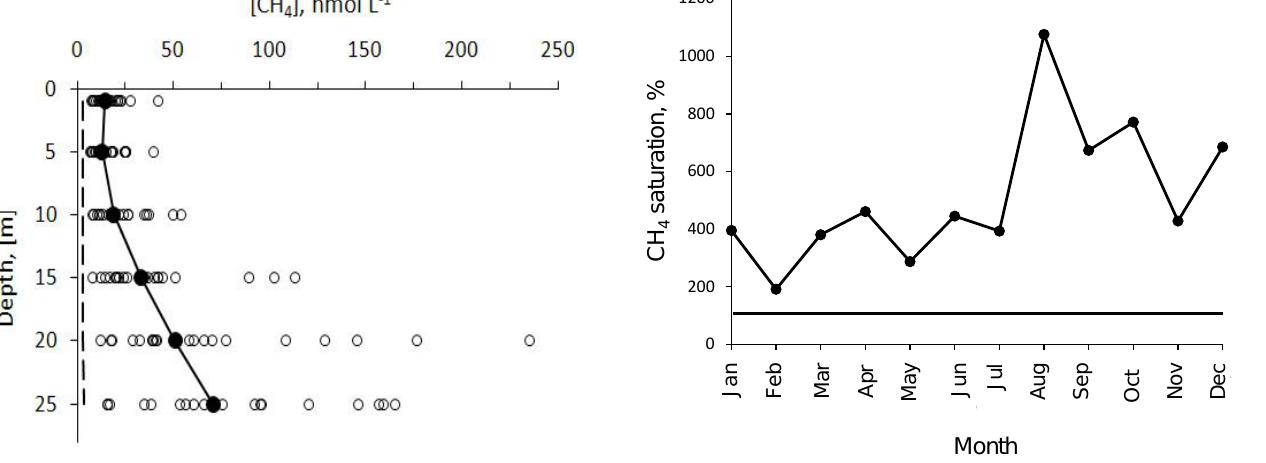
Fig. 3. Depth distribution of CH 4 at Boknis Eck (all data, open circles). The bold line indicates the mean CH 4 profile based on the median values calculated for each depth. The dashed line indicates the corresponding CH 4 equilibrium concentrations.